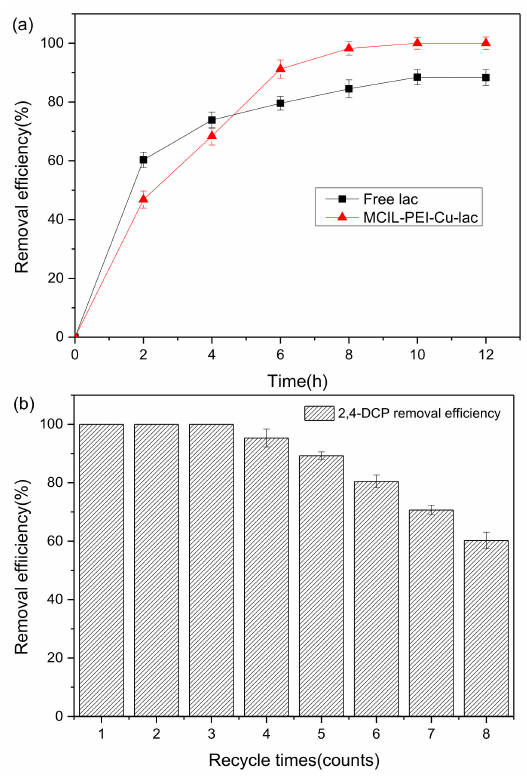
Figure 6. 2,4-DCP removal test of various laccases ( a ). Reusability of MCIL–PEI–Cu–lac ( b